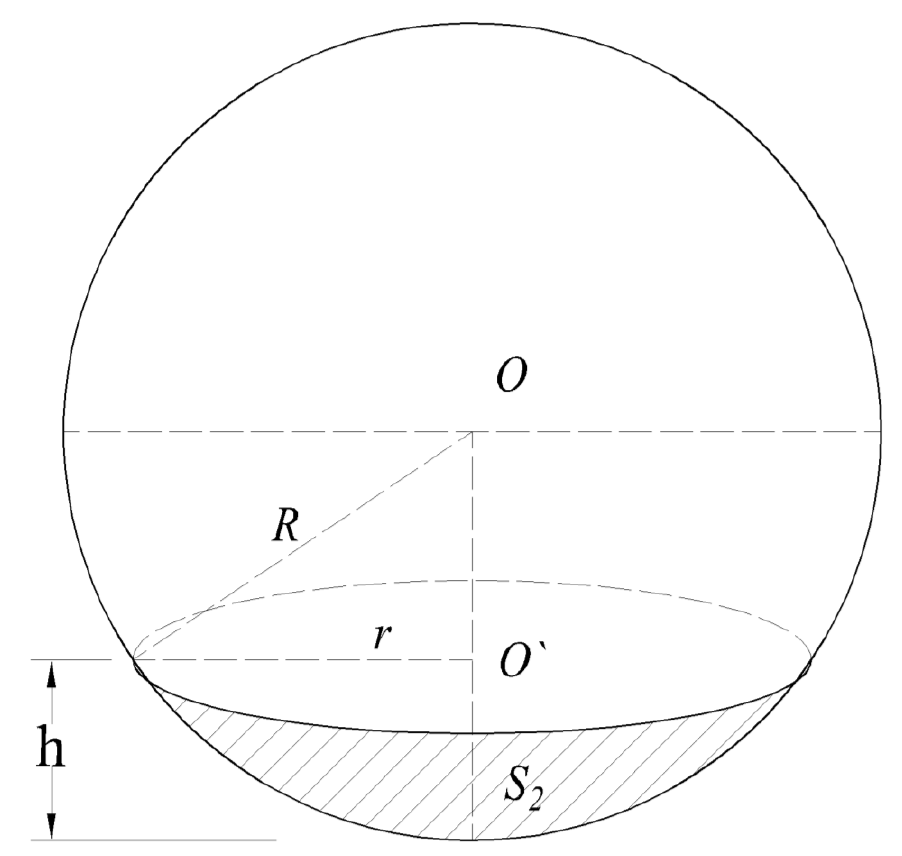
Figure 11. Schematic diagram of spherical crown calculation.